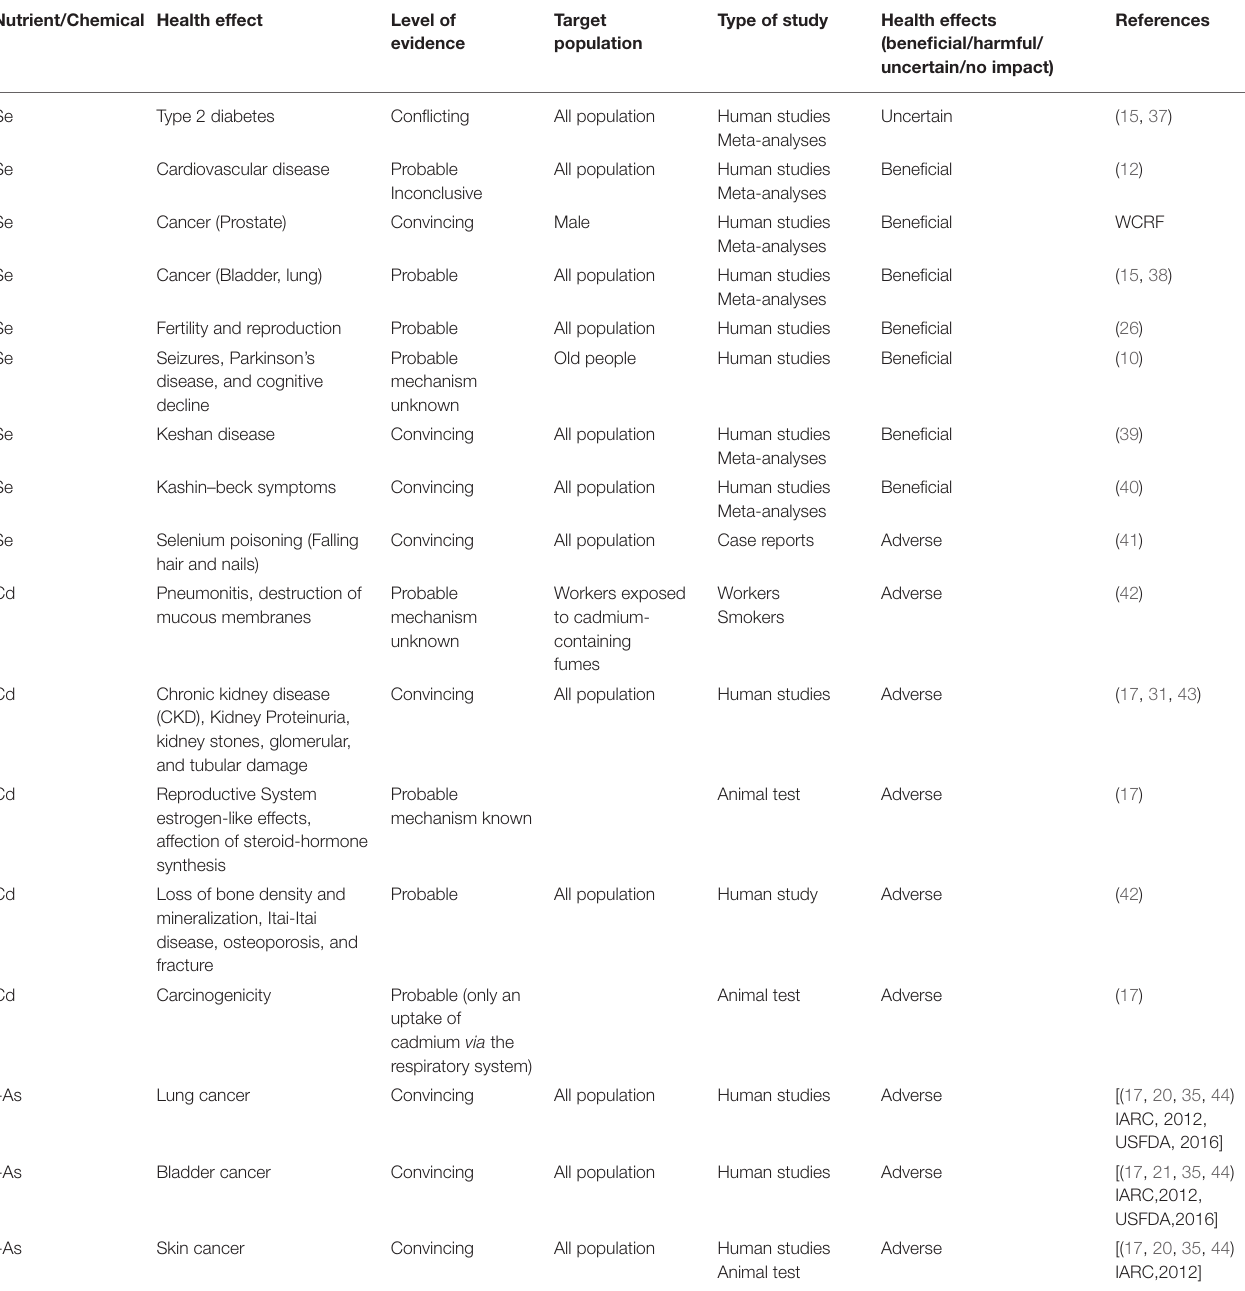
TABLE 1 | Description of the health effects associated with exposure to selenium (Se), cadmium (Cd), and inorganic arsenic (i-As), level of evidence, target population, and type of study. Nutrient/Chemical Health